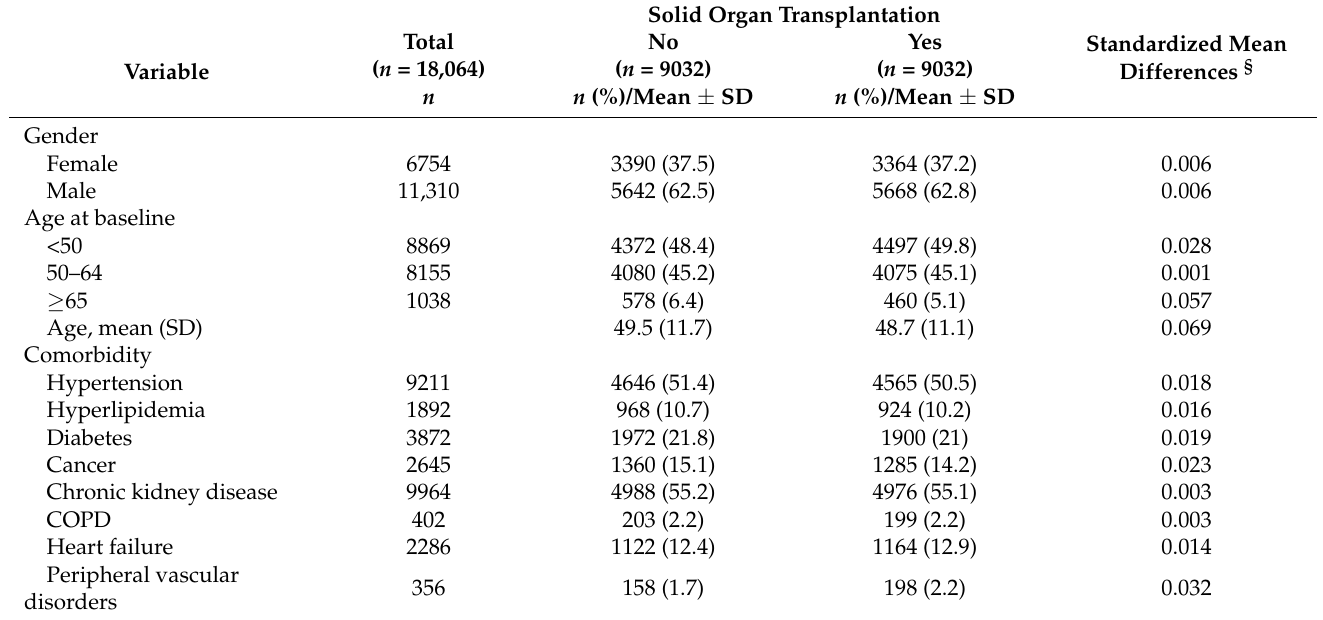
Table 1. Demographic characteristics and comorbidities of patients with new solid organ